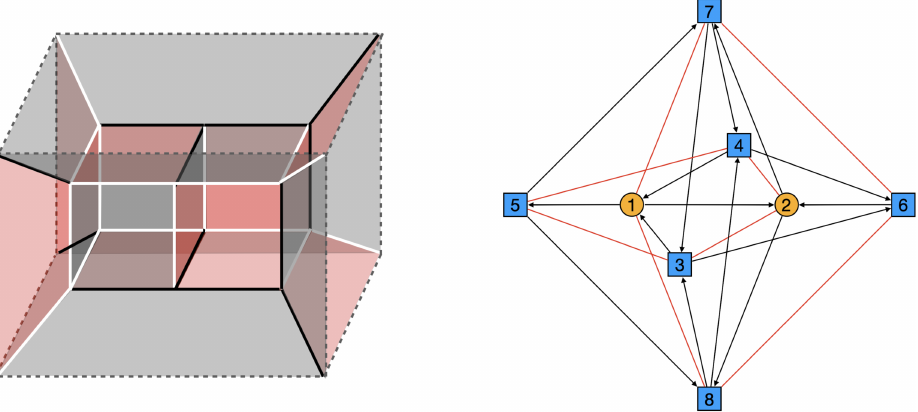
Figure 29 . The 2-cube model and its dual quiver.